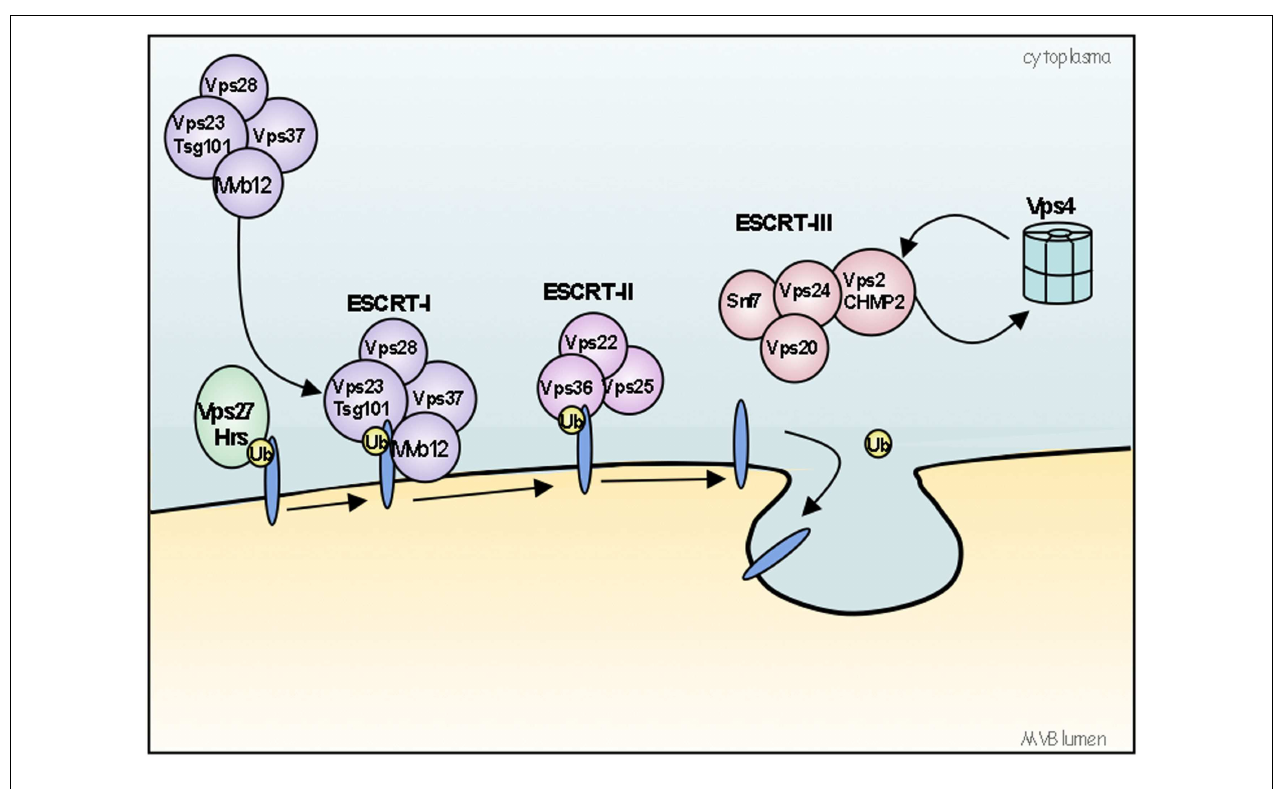
VPS22/Eap30-VPS25/Eap25-VPS36/Eap45), which in turn initiates the oligomerization of ESCRT-III complex (composed of VPS2/CHMP2-VPS20/CHMP6-VPS24/CHMP3-Snf7/VPS32/CHMP4). ESCRT-I and II initiate the invagination of the limiting